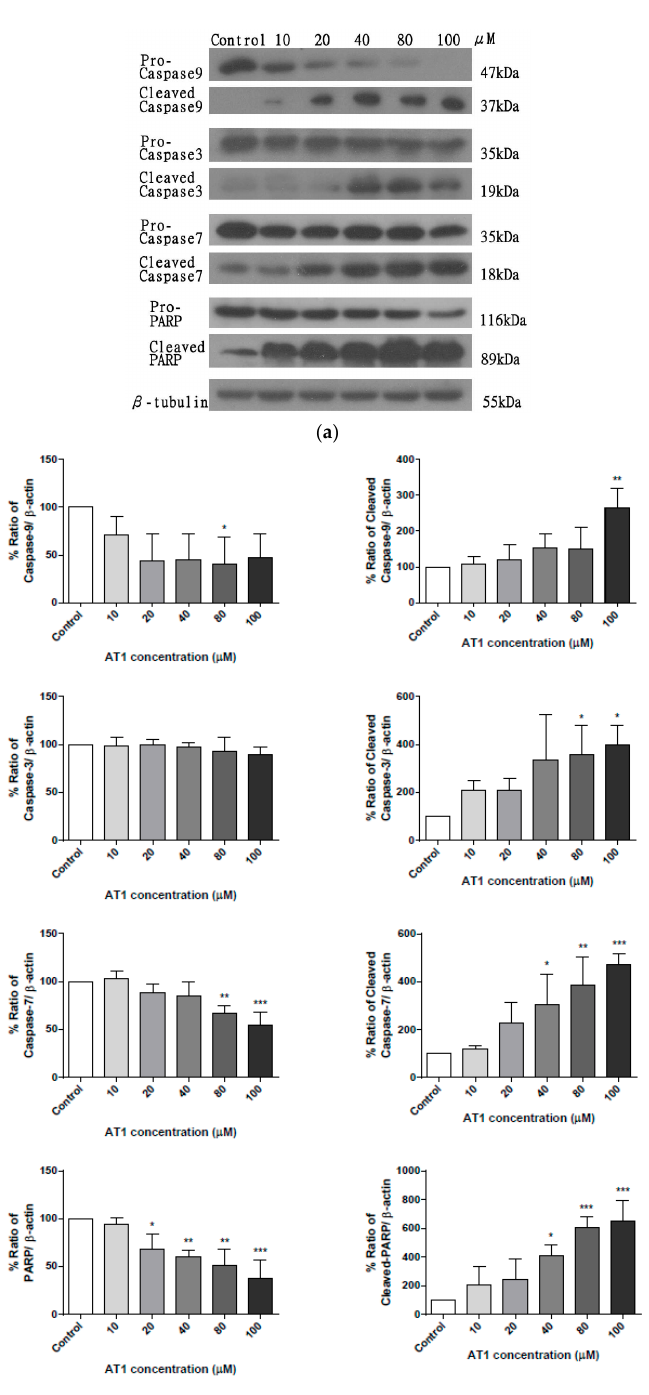
Figure 6. The e ff ects of various concentrations of AT-I on the expression levels of caspases and PARP in HT-29 cells were assessed by western blotting, after cells were treated with AT-I for 48 h. The control group was not treated with AT-I. Total protein concentration of each sample was determined and normalized. β -tubulin was used as a loading control in all western blot experiments. The intensity of each band was quantified by ImageJ image processing program. ( a ) Western blot images of pro-caspase 9, cleaved capase 9, pro-caspase 3, cleaved caspase 3, pro-caspase 7, cleaved caspase 7, pro-PARP, cleaved PARP, and β -tubulin. The images are representative of three independent experiments. ( b ) Each bar chart presents the percentage ratio of each investigated protein to β -tubulin. Data are shown as mean ± SD, n = 3. Significant di ff erences are indicated by * p < 0.1, ** p < 0.01, *** p < 0.001 as compared with the control